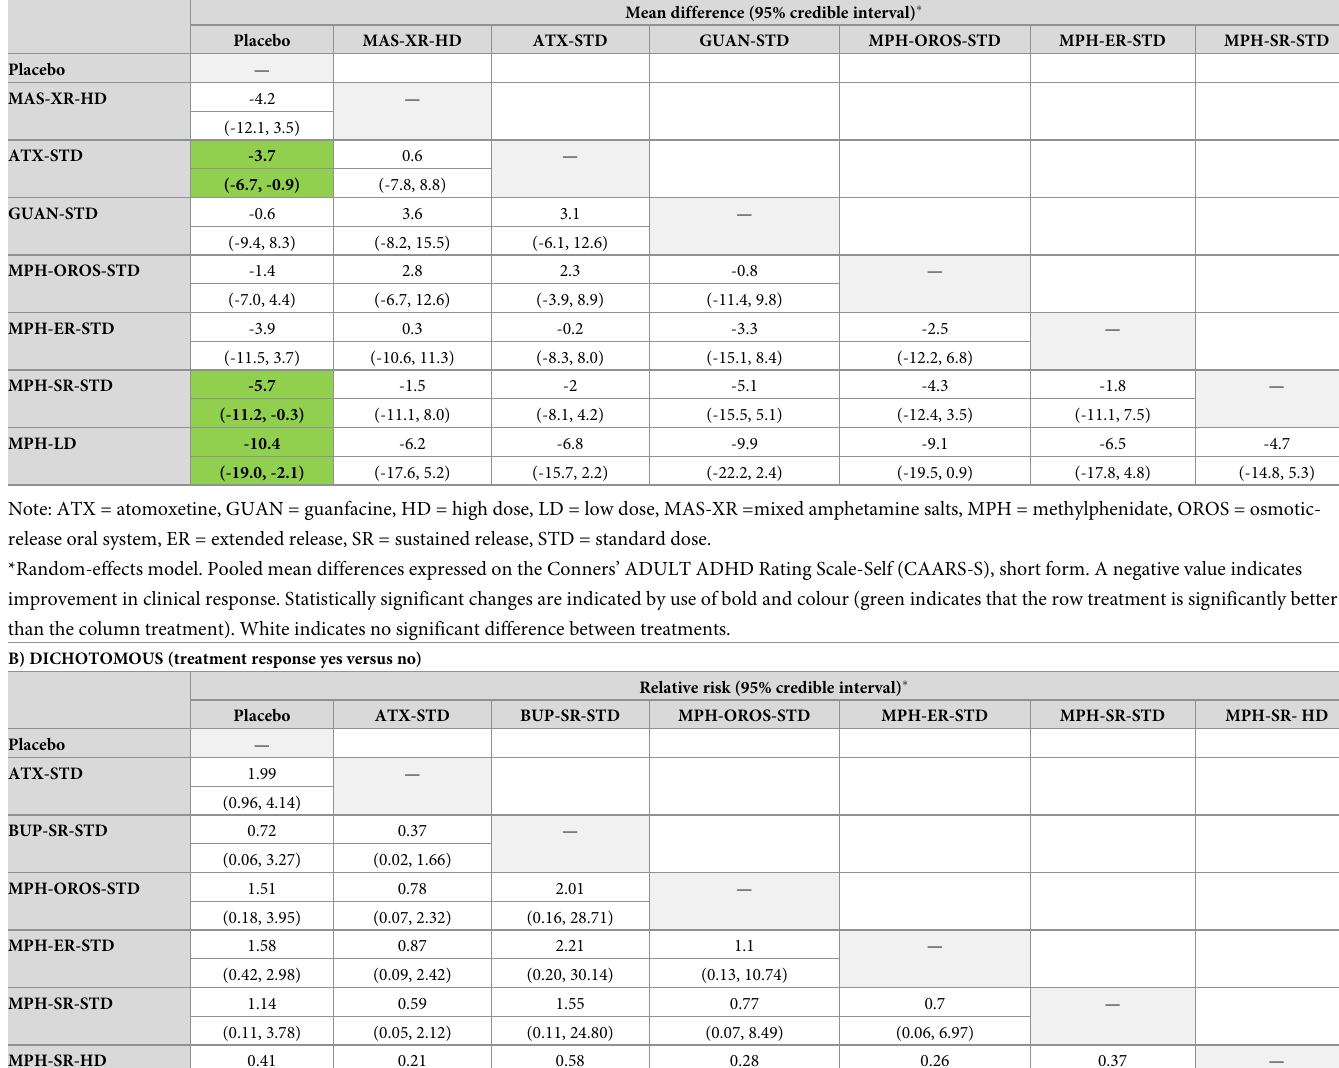
Fig 6. Network diagrams for patient-reported clinical response. Treatment nodes are proportional to the number of patients who took the corresponding treatment, while the width of each edge is proportional to the number of trials included in the comparison. Intervention abbreviations: ATX = atomoxetine, GUAN = guanfacine, HD = high dose, MAS-XR = mixed amphetamine salts, MPH = methylphenidate, OROS = osmotic-release oral system, ER = extended